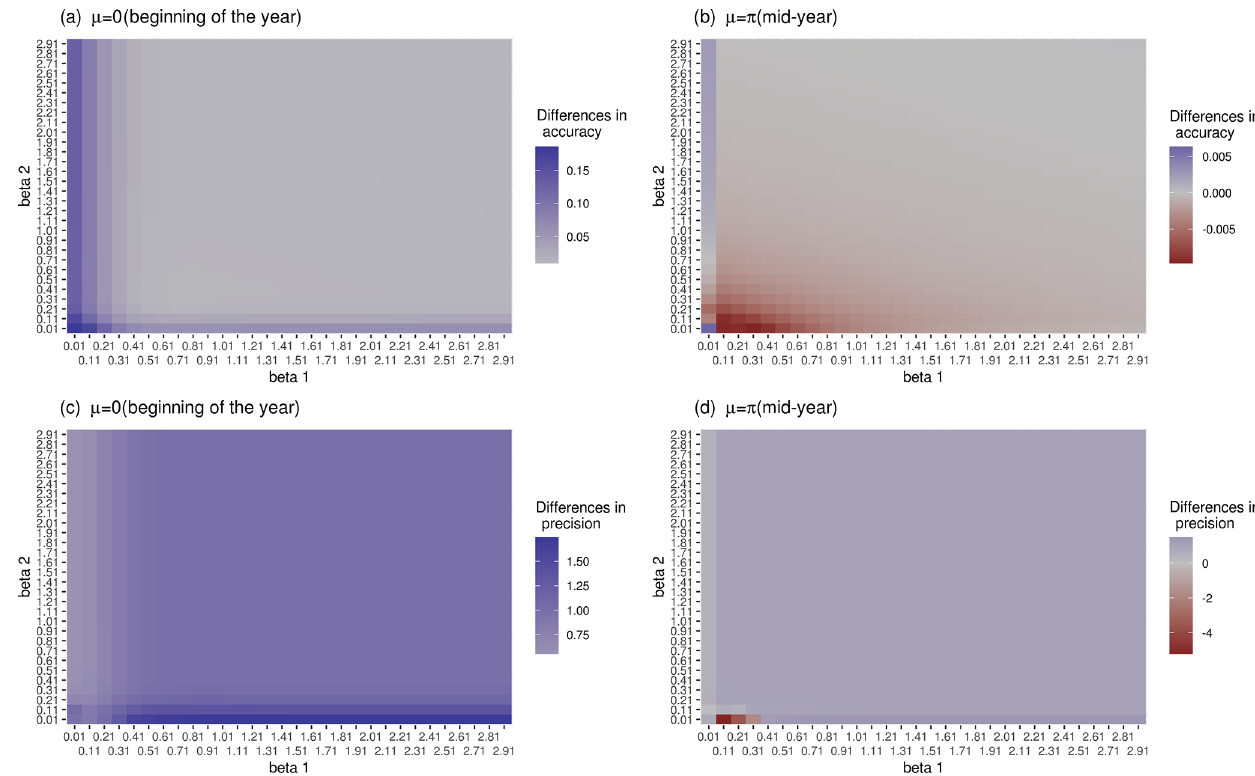
Figure 3. Accuracy and precision of linear and circular regression models by recovering the original regression coefficients of a circular regression. (a, c) µ = 0 (maximum at the beginning of the year). (b, d) µ = pi (maximum midyear). Panels (a) and (b) correspond to the differences in accuracy between the models. Panels (c) and (d) correspond to the differences in the precision between the models. Blue means better performance of the circular model compared with the linear model, and red means higher performance of the linear model.